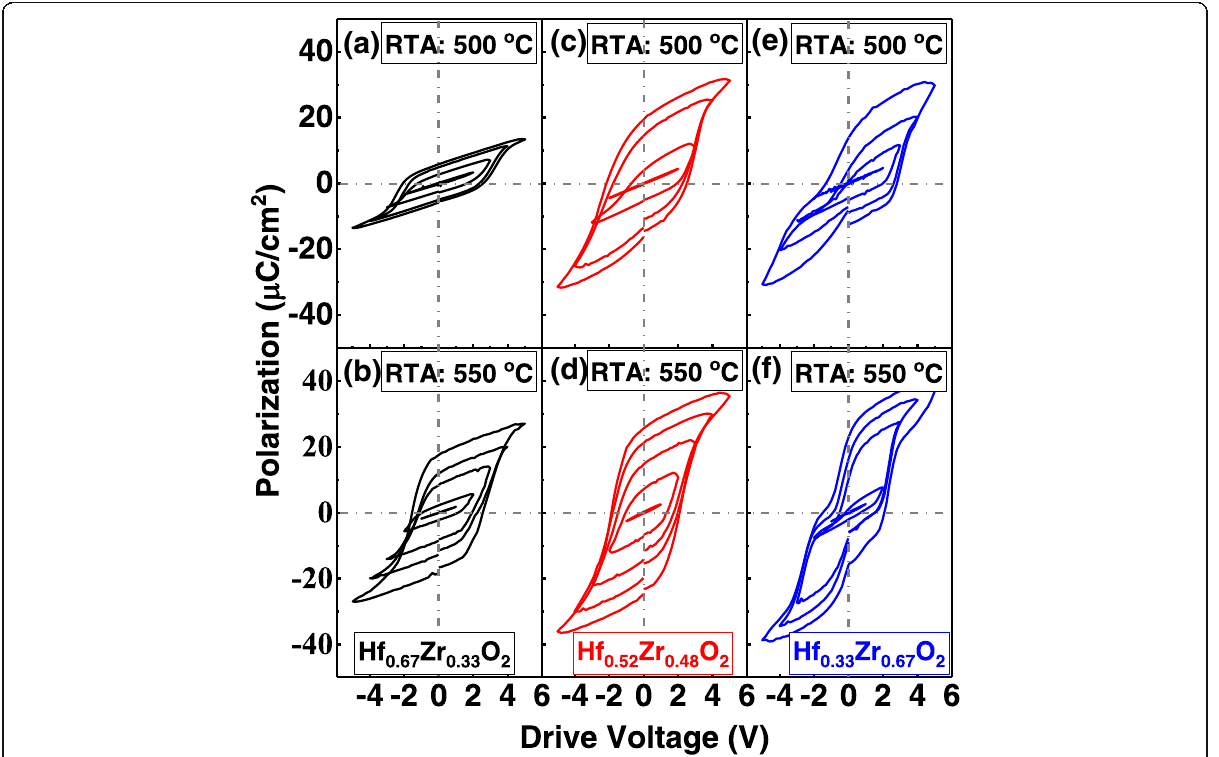
Fig. 3 Measured P-V curves of the Hf 1-x ZrxO2 films with different Zr compositions annealed at 500 and 550 o C. ( a ) and ( b ) are the Hf 0.67 Zr 0.33 O 2 film annealed at 500 and 550 o C, respectively. ( c ) and ( d ) are the Hf 0.52 Zr 0.48 O 2 film annealed at 500 and 550 o C, respectively. ( e ) and ( f ) are the Hf 0.33 Zr 0.67 O 2 film annealed at 500 and 550 o C, respectively. With the post annealing temperature increases from 500 to 550 o C, the P-V curves of the Hf 1-x Zr x O 2 tend to be saturated in a sub-loop state. An evolution ferroelectric to an antiferroelectric-like behavior is observed with the Zr composition